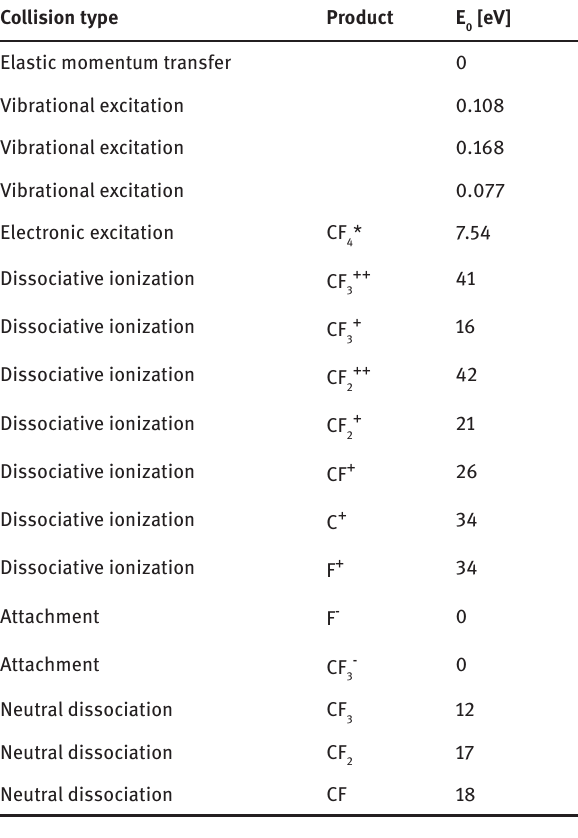
collision processes considered in the model. 4